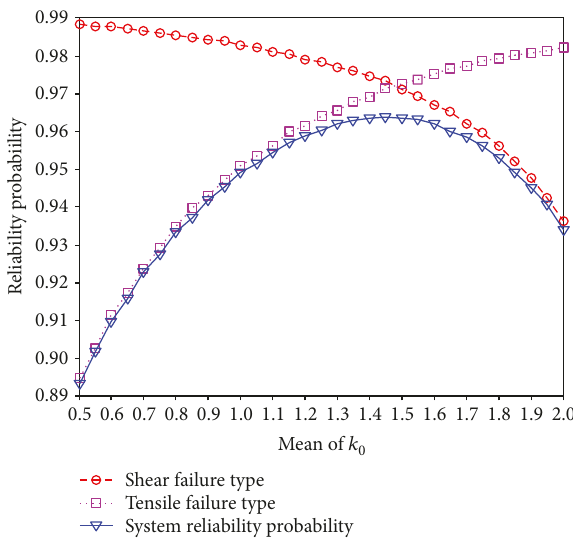
Figure 6: Relationship between the mean value of k 0 and shear and tensile failure in key strata and the reliability probability of the